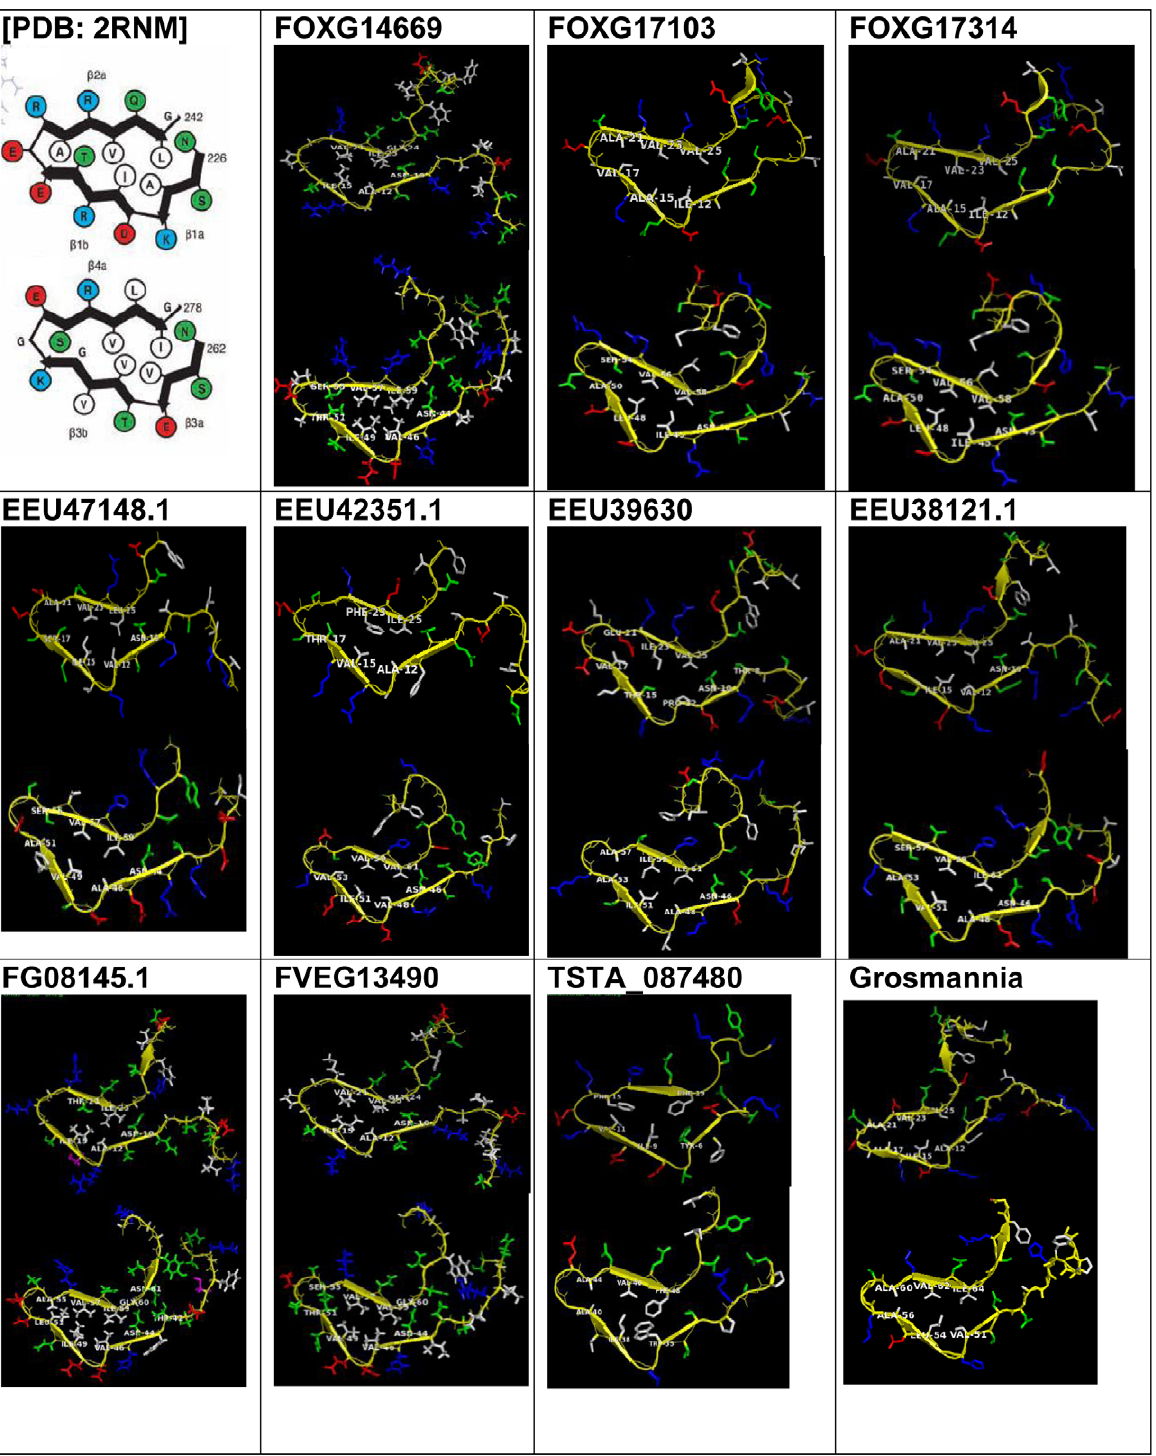
Figure 4. Models of HET-s homologs with structural homology to the HET-s PFD. The original solenoid [PDB: 2RNM] [6,7] is shown in the top left corner. Ten structural homologs are represented, including the small s protein homolog from G. calivigera . The structure of FG10600.1 has been shown by Wasmer et al [10] and is not included here. For each structure, two rungs for each solenoid are represented, with the first rung at the top. Amino acids are color-coded as follows: acidic (Asp, Glu) in red, basic (Arg, Lys, His) in blue, nonpolor (Met, Phe, Pro, Trp, Val, Leu, Ile, Ala) in white, polar (Ser, Thr, Asn, Gln, Tyr) in green, and the protein backbone in yellow.